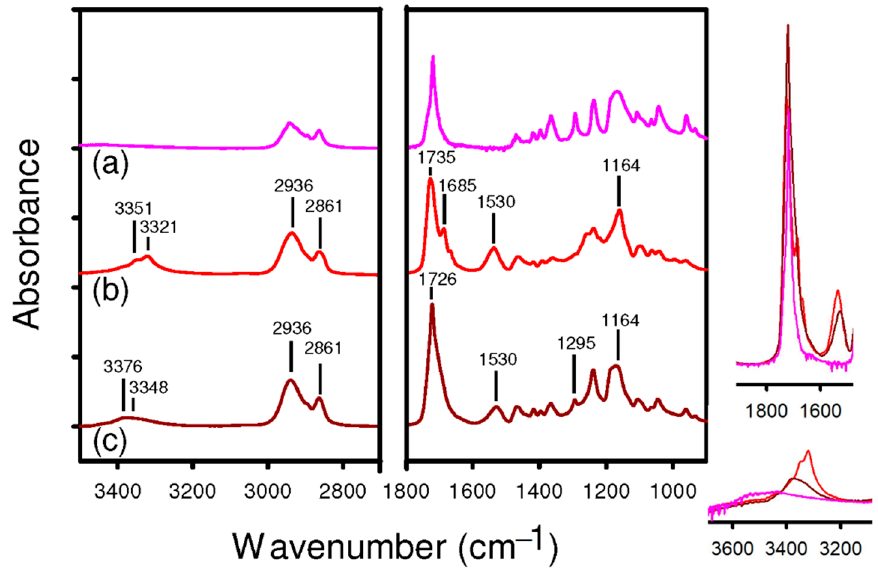
Figure 1. ATR-FTIR spectra of the PCL-diol ( a ), the PU-BDO ( b ) and the PU-DMPA ( c ). Generally, C=O stretching vibration of esters and urethanes manifests itself as peaks between 1600 cm − 1 and 1800 cm − 1 . In the PU-BDO spectrum, the peak at 1735 cm − 1 and the shoulder peak at 1685 cm − 1 were assigned to free ester or urethane carbonyl groups and hydrogen-bonded (H-bonded) ester or urethane carbonyl groups, respectively [30,31]. In the PU-DMPA spectrum, although no separate peaks were observed in this region, the peak at 1726 cm − 1 was strong and broad compared to the two peaks for the PU-BDO. Note that, in addition to the carboxyl group in soft segments and urethane groups in hard segments, there are carboxyl groups in the hard segments and all these groups might contribute to H-bonded carbonyl groups. Both the PU-BDO and the PU-DMPA exhibited 2936 cm − 1 and 2861 cm − 1 absorptions, corresponding to symmetric and asymmetric C-H stretch- ing from CH 2 , respectively.